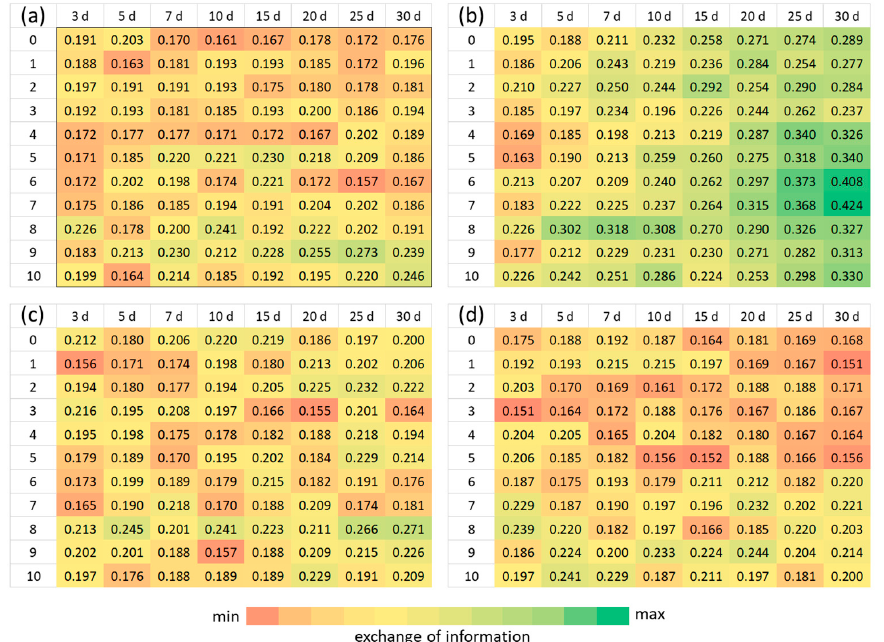
Figure 11. Values of the MIC for different cumulative rainfall (3 days to 30 days) and different shifts of the displacements–rainfall series (lag from 0 to 10 days). Results for the rotational slide (Figure 7) related to the ( a ) T124 descending orbit and ( b ) T146 ascending orbit, and for the earth flow (Figure 8) for the ( c ) T124 descending orbit and ( d ) T146 ascending orbit. Greenish cells indicate a higher MIC (higher exchange of information between the two series) compared to the reddish ones (lower MIC).